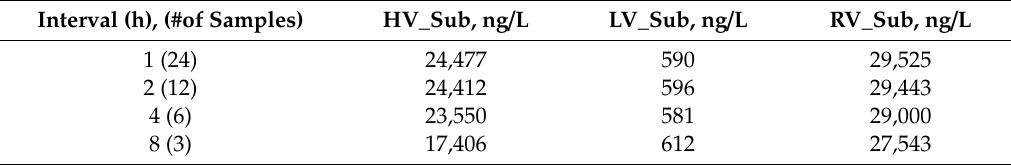
Table 6. Average concentrations of the three substances in the case of flow proportional sampling (with the di ff erent number of samples